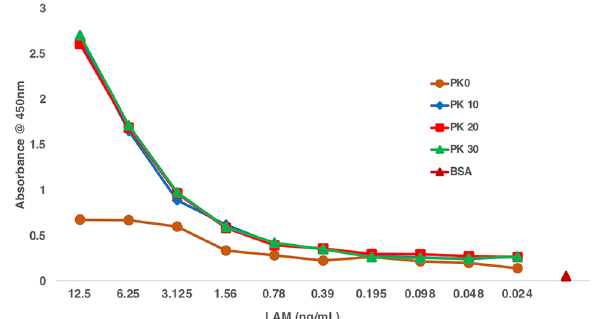
Figure 1. Inactivation of Proteinase K before ELISA, Urine from a healthy volunteer from TB non endemic region was spiked with Mtb (CDC1551) LAM (ranging from 12.5 to 0.02 ng/mL) and pretreated with Pro K (200 ug/mL) to release LAM. Before ELISA, Pro K was inactivated at different time points (0 min to 30 min) to ensure complete inactivation. At 0 min inactivation after pretreatment, the ELISA signal is very weak (brown line), however, with 10 (blue line), 20 (red line) and 30 (green line) min inactivation a proper standard curve is achieved with no difference between the inactivation times.